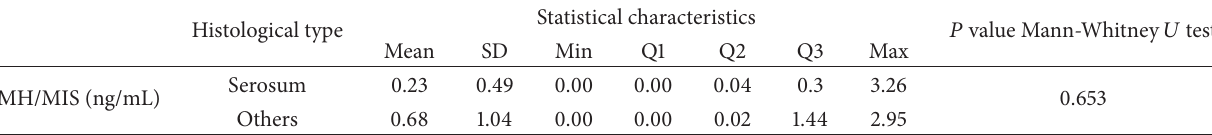
Table 4: AMH concentration in relation to histological type of cancer.